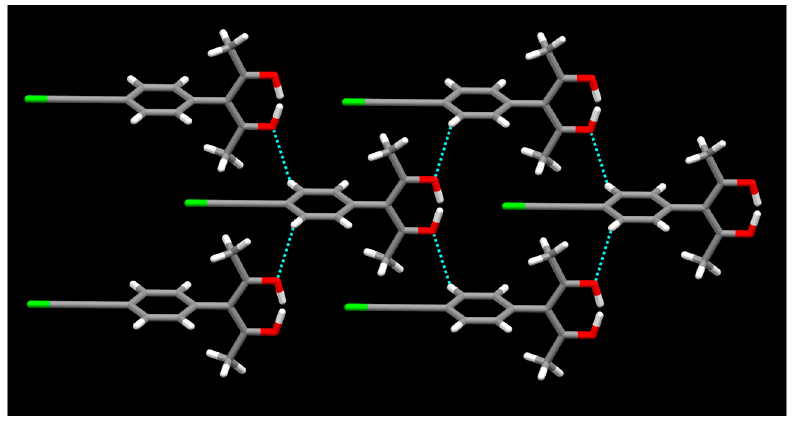
Figure 1. Part of the crystal structure of L1 (color codes: red—oxygen; green—chlorine).